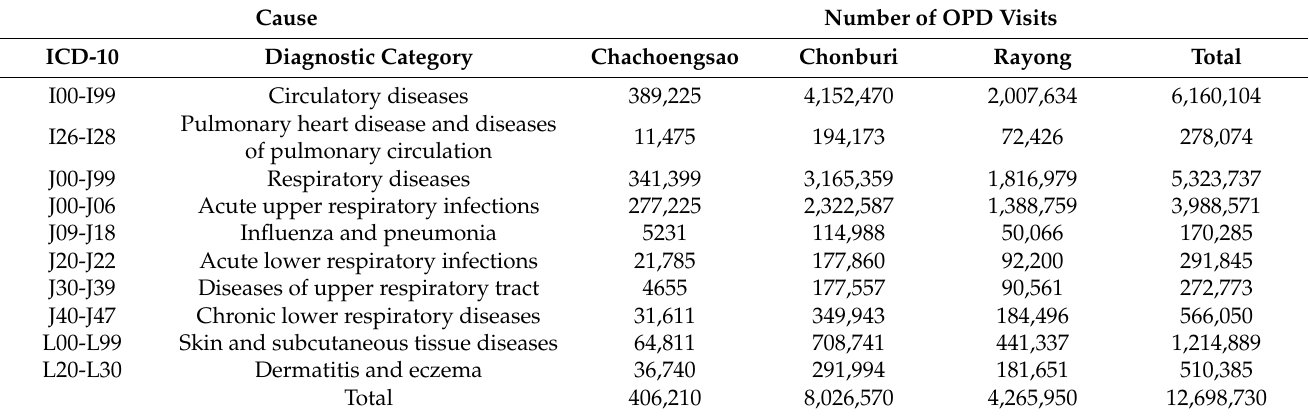
Table 2. Summary statistics for outpatient department (OPD) visits with various causes in the three provinces in the Eastern Economic Corridor of Thailand between 2013 and 2019.